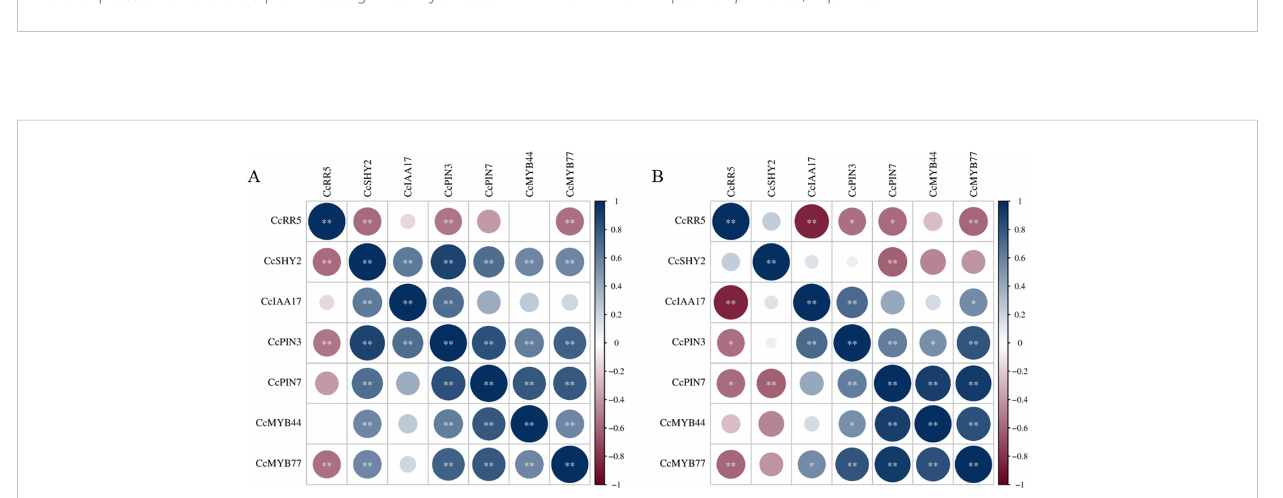
FIGURE 8 The expression levels of root-related genes in the leaves (A) and roots (B) of CcRR5 transgenic plants. WT, wild type; OE, CcRR5 overexpression plants; RNAi, CcRR5 silence plants. Each error bar indicated the mean ± SD ( n = 3). The asterisk indicated that the expression of genes in overexpression and silence plant was signi fi cantly different with that in the WT plants. * p < 0.05; ** p < 0.01.